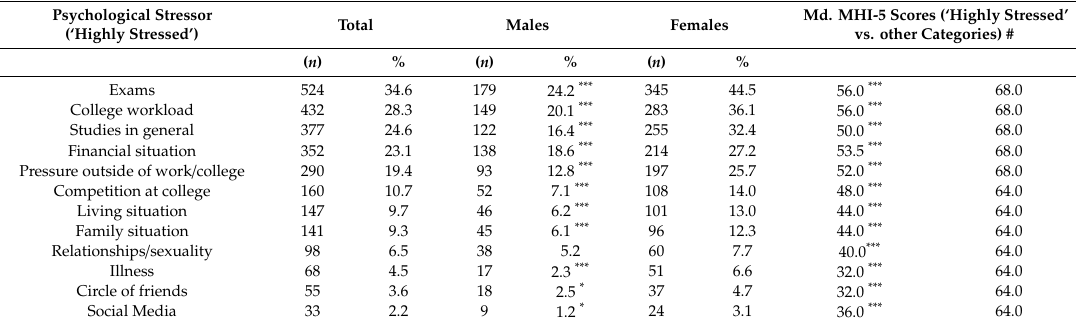
Psychological stressors (‘highly stressed’) by sex and di ff erences in MHI-5